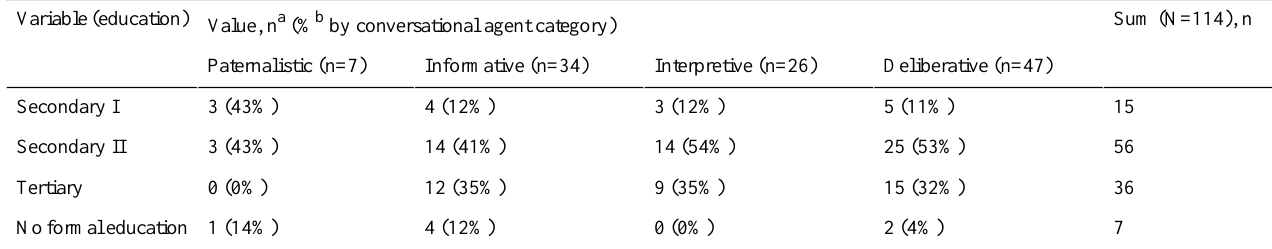
Table 4. Conversational agent preferences by educational